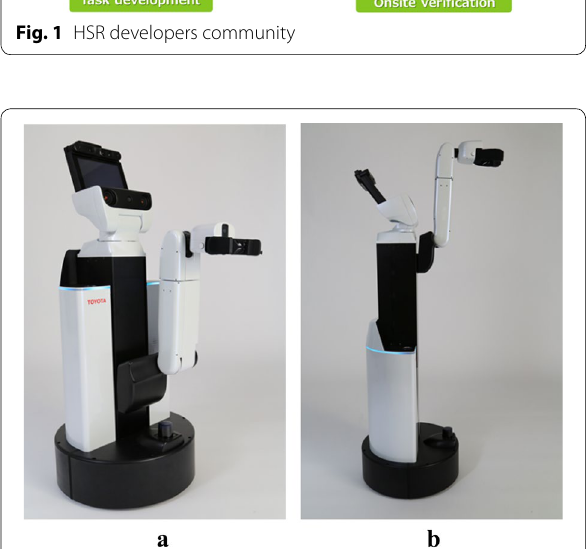
Fig. 2 Human Support Robot (HSR) [2]. a Normal posture, b Extended posture